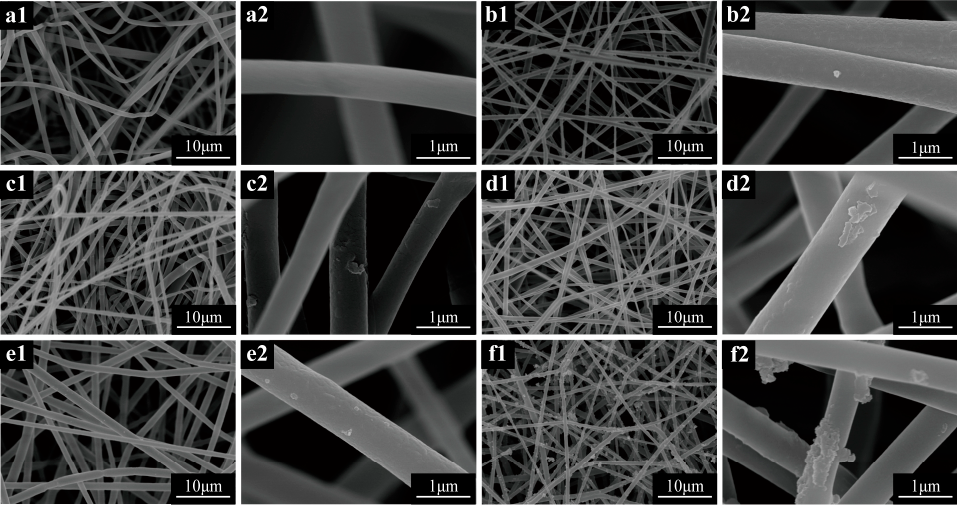
Figure 1. SEM photographs of PLA nanofibers immersed in SBF for different time: ( a1 , a2 ) 0-day; ( b1 , b2 ) 1-day; ( c1 , c2 ) 3-day; ( d1 , d2 ) 5-day; ( e1 , e2 ) 7-day; ( f1 , f2 ) 21-day.